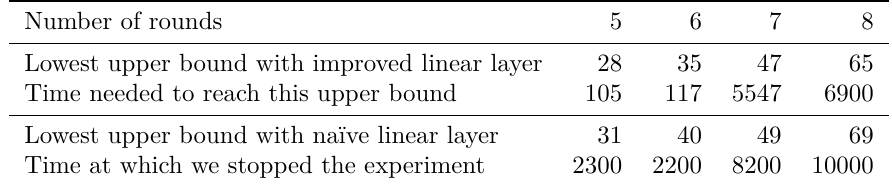
Table 7: Time in seconds to reach the lowest upper bound for the minimum number of active Sboxes for the